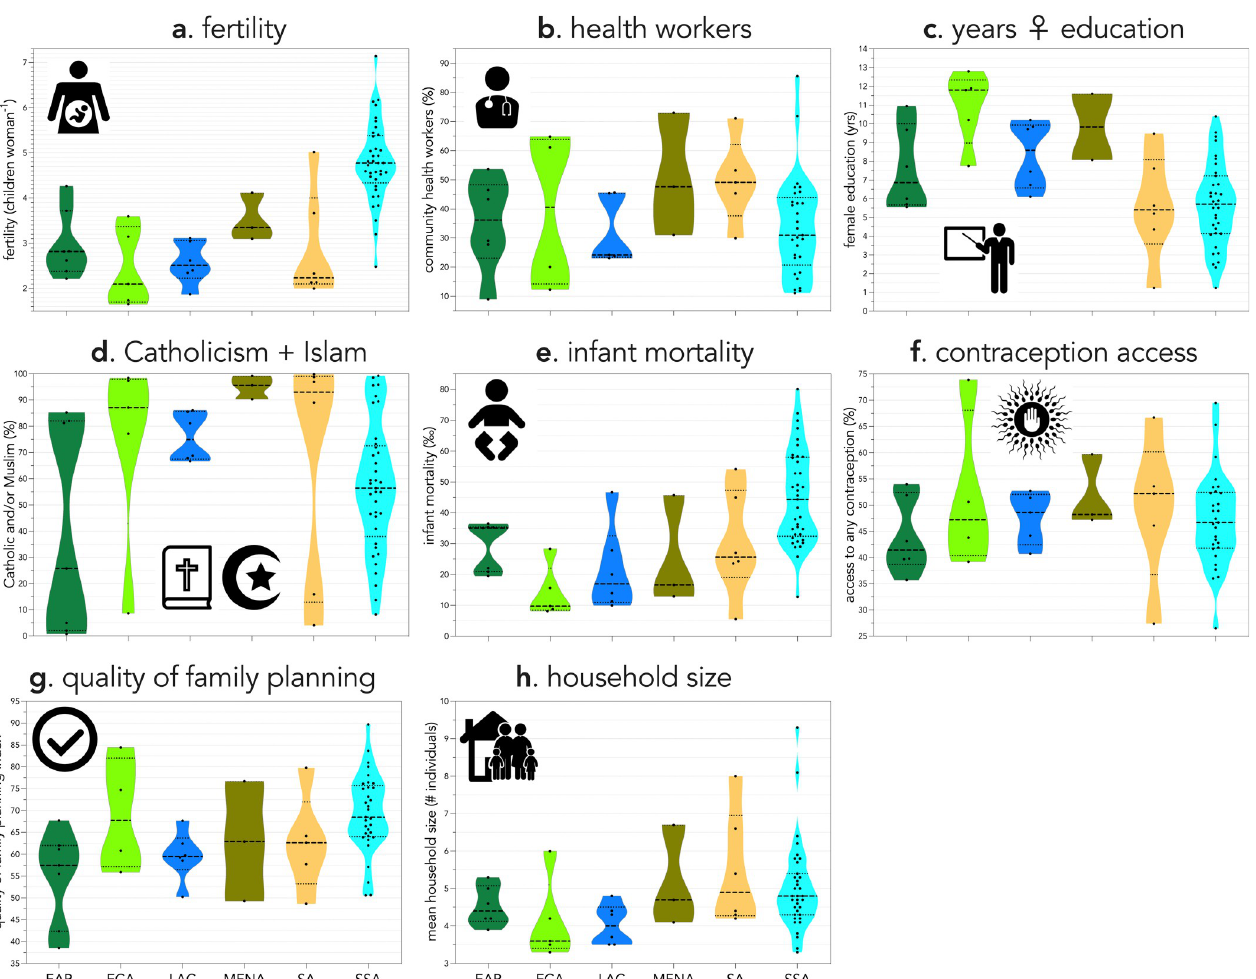
Fig 1. Violin plots of country-level raw values for a . fertility (children woman -1 ) and the highest-ranked variables from each of the six initial modelling phases — b . population with access to community health workers (%), c . female years of education completed, d . population claiming adherence to Catholicism or Islam (%), e . infant mortality (per 1000 births), f . population with access to any form of contraception (%), g . quality of family planning index, h . mean number of household members. The 64 low- and middle-income countries with full data included in the analysis are classed into four world regions (EAP = East Asia and Pacific; ECA = Europe and Central Asia; LAC = Latin America and Caribbean; MENA = Middle East and North Africa; SA = South Asia; SSA = sub- Saharan Africa). Country codes per region (3-letter ISO): EAP (KHM, IDN, LAO, MMR, PNG, PHL, TLS); ECA (ALB, ARM KGZ, TJK, TUR), LAC (COL, DOM, GTM, HTI, HND, PER); MENA (EGY, JOR, YEM); SA (AFG, BGD, IND MDV, NPL, PAK); SSA (AGO, BEN, BFA, BDI, CMR, TCD, COM, COD, COG, CIV, GNQ, ETH, GAB, GMB, GHA, GIN, KEN, LSO, LBR, MDG, MWI, MLI, MRT, MOZ, NAM, NER, NGA, RWA, STP, SEN, SLE, ZAF, TZA, TGO, UGA, ZMB,